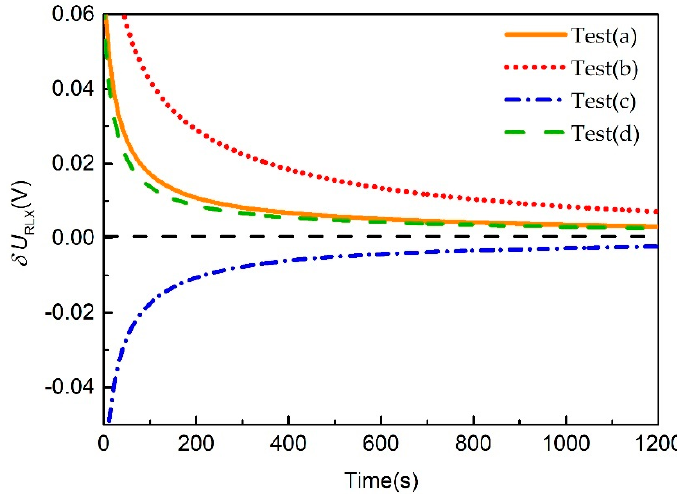
Figure 3. Relaxation voltage curve of pretests.